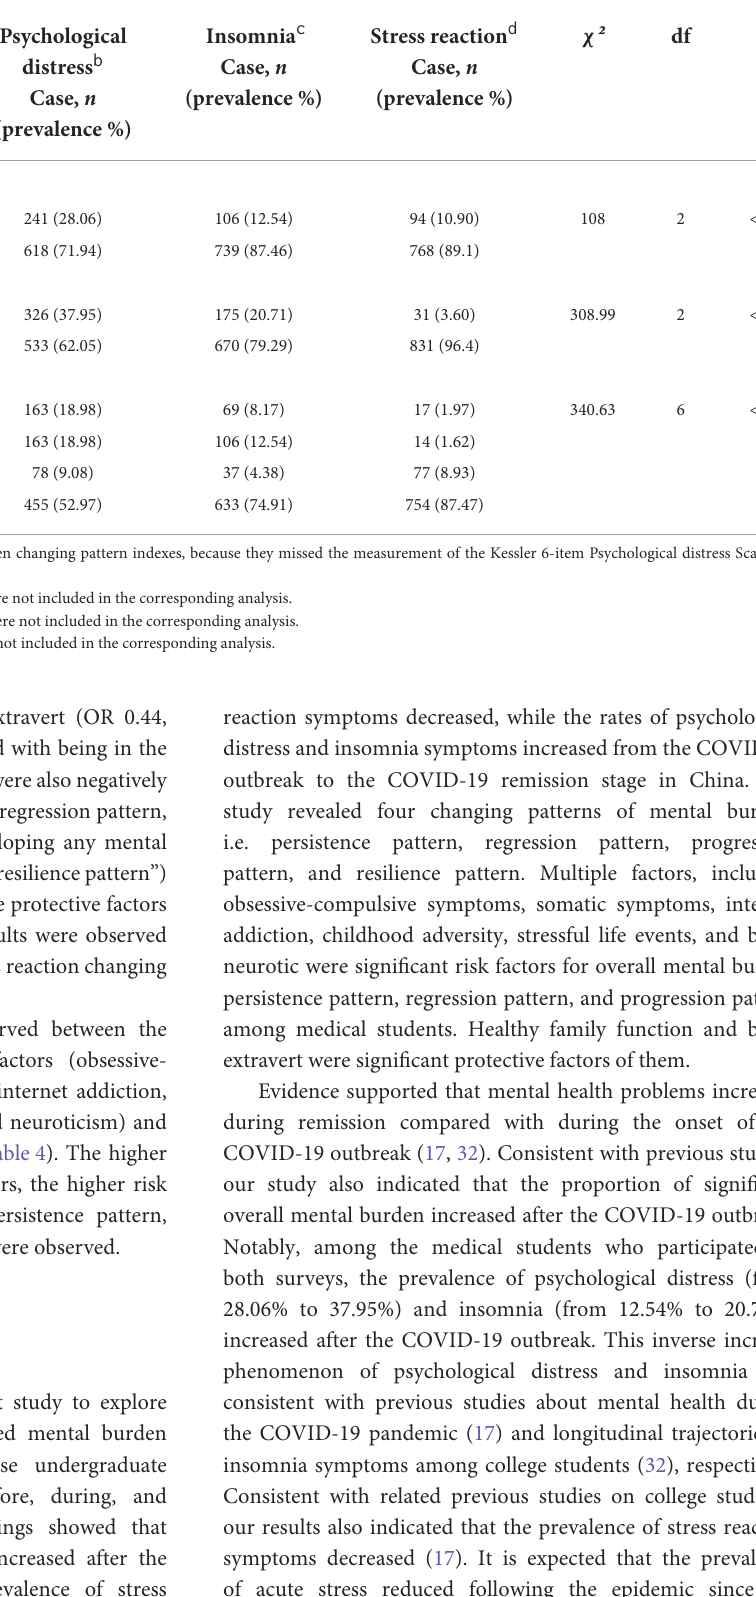
Overall Mental burden a Case, n (prevalence %)